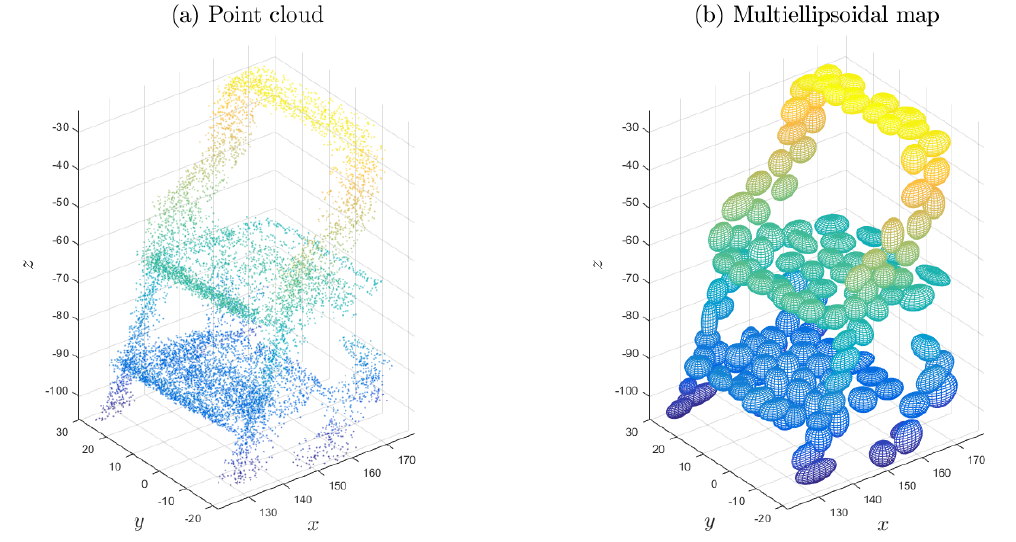
Figure 3. Experiment